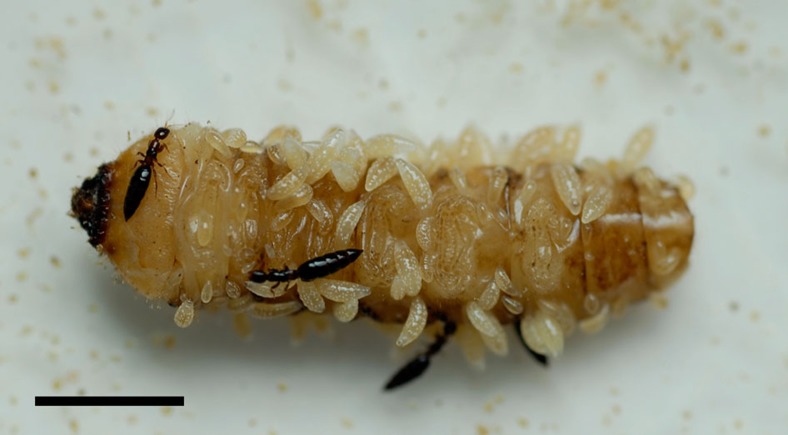
Multiple cofoundresses engaged in cooperative brood care.Adult Sclerodermus harmandi females tending a brood of larvae developing on a pine sawyer beetle (Monochamus alternatus) larva. Scale bar, 5 mm.